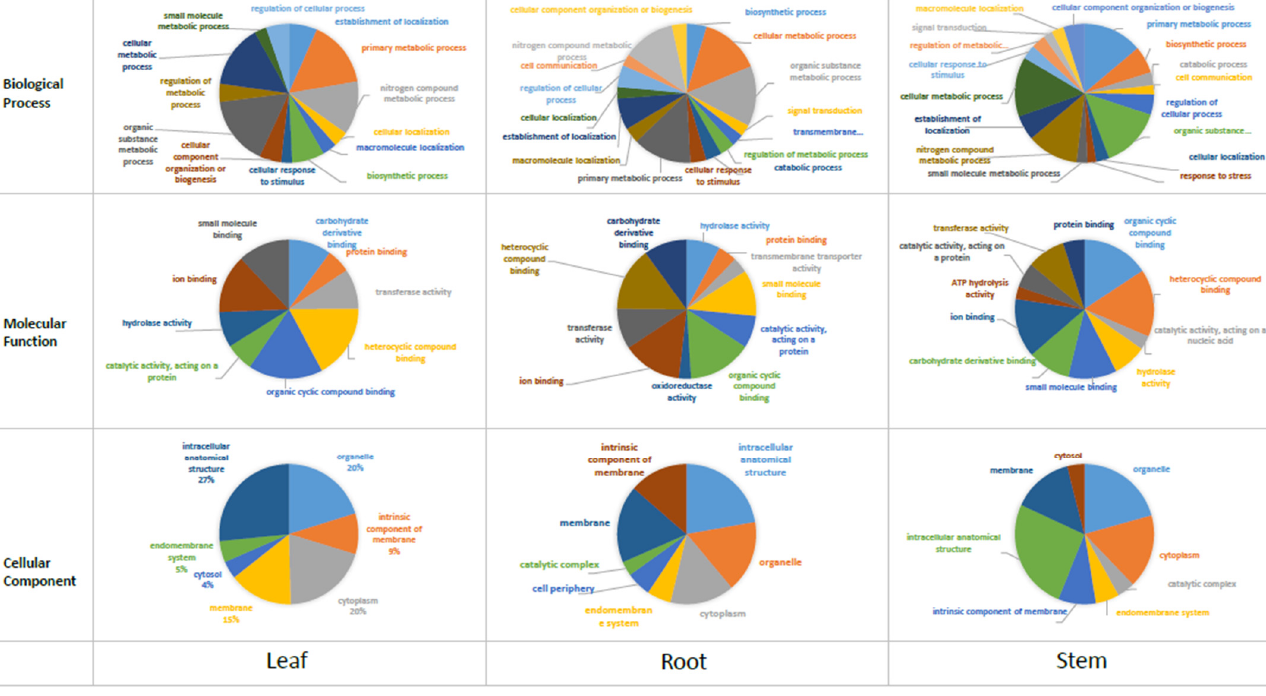
Figure 6. GO analysis of the organ-specific-expressing